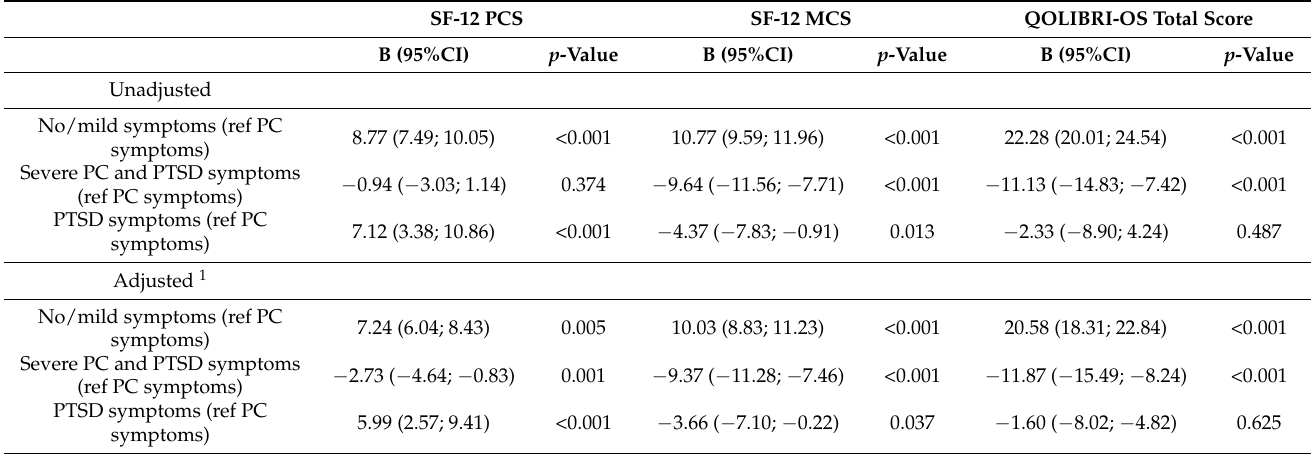
Table A1. Linear regression analysis on HRQoL at 6